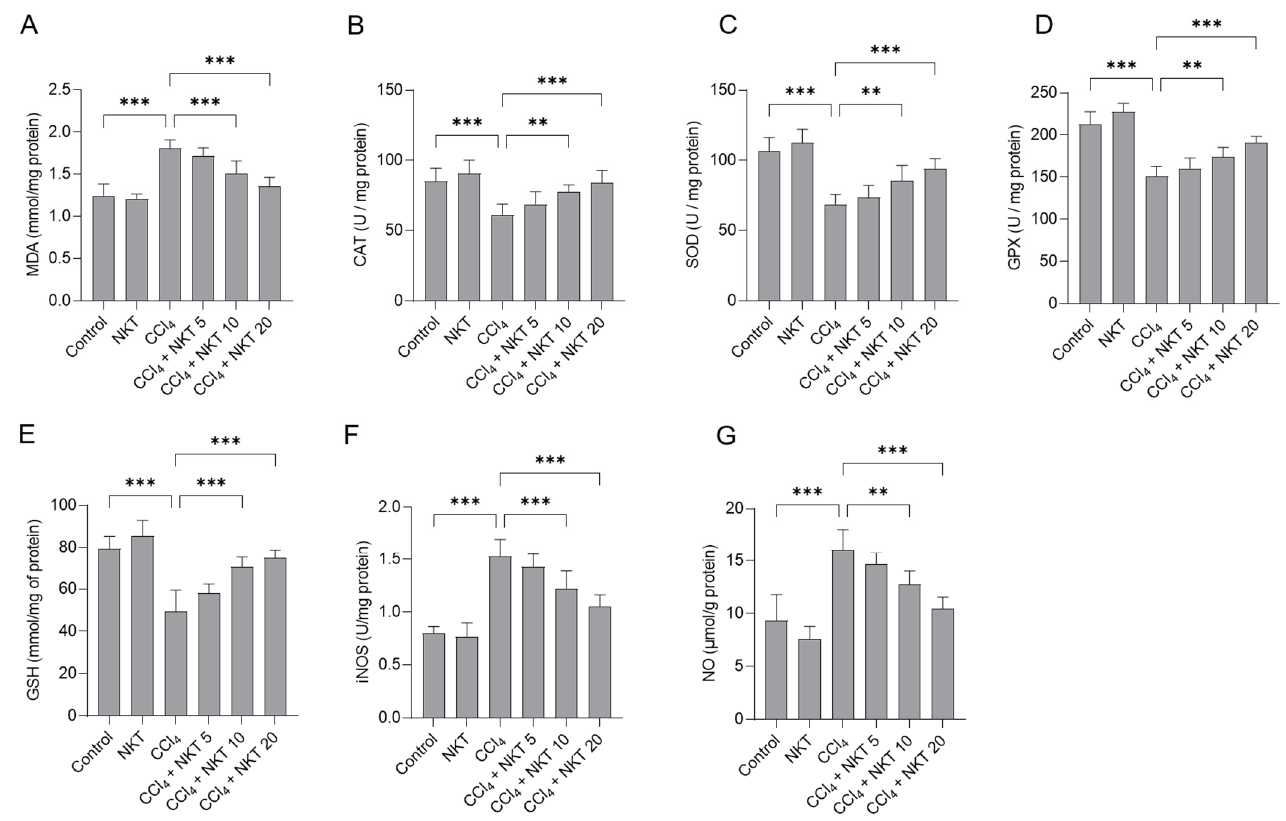
Figure 5. NKT pre-treatment attenuates CCl 4 exposure-induced oxidative damage in the kidneys of mice. Mice were treated first with NKT at 5, 10, and 20 mg/kg/day for seven successive days, then were treated with 0.3% CCl 4 . After 24 h, MDA levels ( A ), and the activities of catalase (CAT) ( B ), superoxide dismutase (SOD) ( C ), glutathione (GSH) ( D ), glutathione peroxidase (GPX) ( E ), and inducible nitric oxide synthase (iNOS) ( F ) activities, and levels of nitric oxide (NO) ( G ) in the kidney tissues were measured, respectively. Data are shown as mean ± S.D. ( n = 8 in each group). ** p < 0.01, and *** p < 0.001.